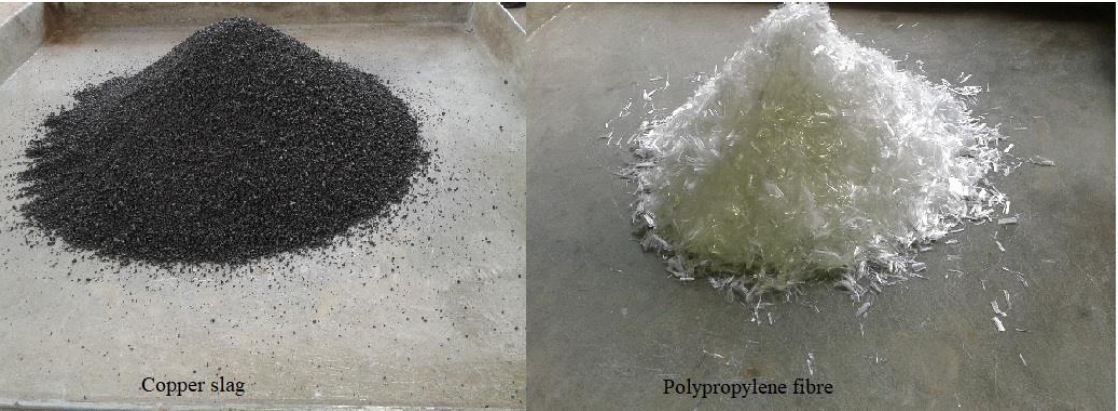
Figure 1. CS and fibrillated PPF.